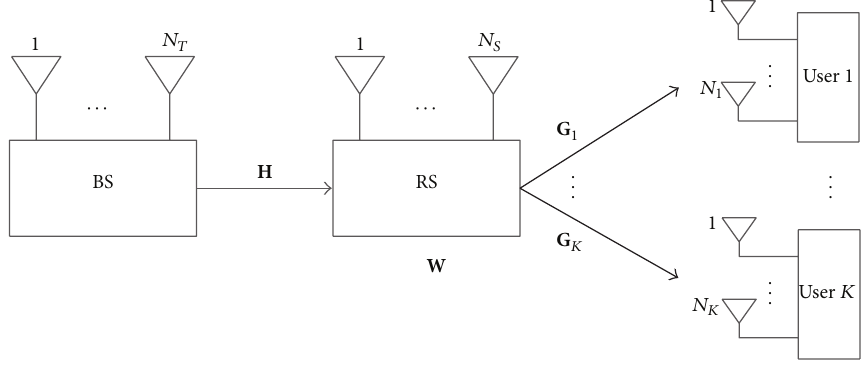
Figure 1: System model of the MIMO relay broadcasting